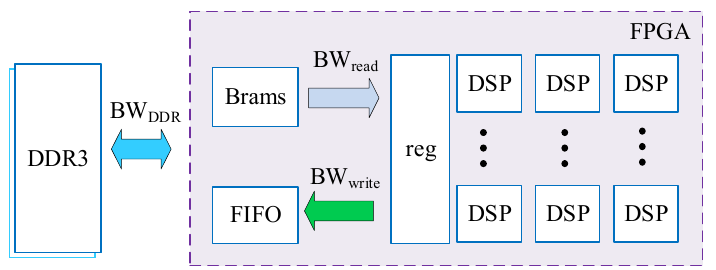
Figure 4. Bandwidth supply and demand relationship in the multi-level cache structure.